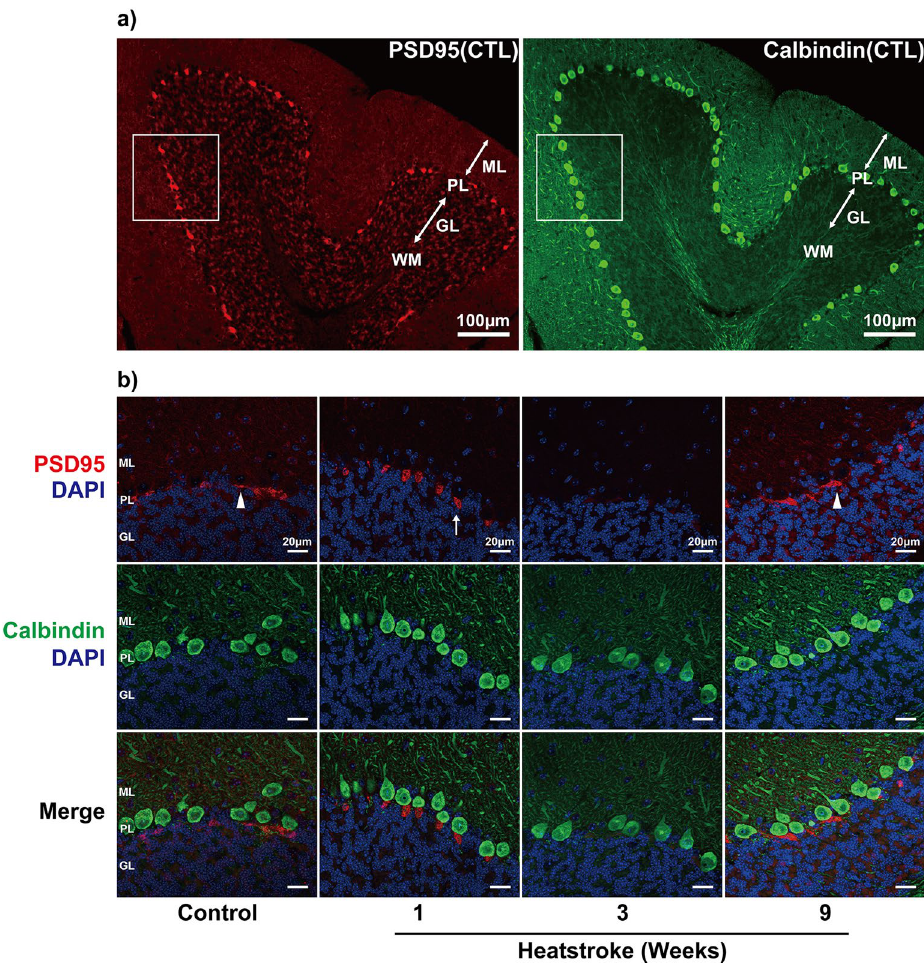
Figure 4. Immunostaining of postsynaptic density 95 in Purkinje cells after heatstroke. ( a ) Representative images of anti-postsynaptic density 95 (PSD95) (red), a postsynaptic marker, and calbindin (green) immunoreactions in the cerebellum in control mice. The PSD95 immunoreactions were observed in the Purkinje cells. Blue is due to 4 ′ ,6-diamidino-2-phenylindole nucleic staining. ( b ) The higher magnified images indicated that the PSD95-immunoreactions were located in the axon hillock of each Purkinje cell. The immunoreactions in the control group were widely recognized, such as plates, with relatively lower density in the Purkinje cells (arrowhead). The PSD95 immunoreactions 1 week after heatstroke (arrow) were gathered and concentrated in the axon hillock of the Purkinje cells like pen points. The immunoreactions appeared to have attenuated at 3 weeks and reappeared more heterogeneously at 9 weeks. ML molecular layer, PL Purkinje cell layer, GL granular cell layer, WM white matter, CTL